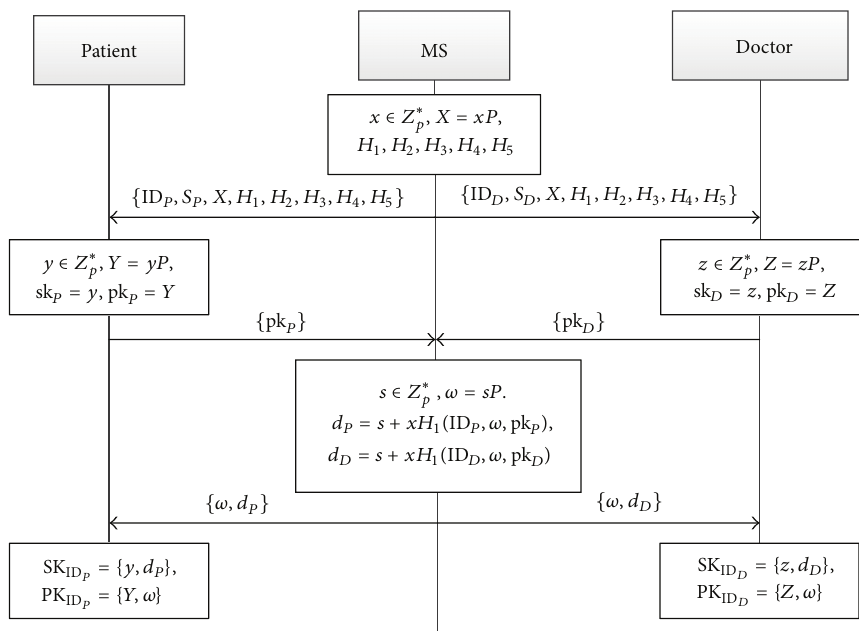
Figure 1: Initialization